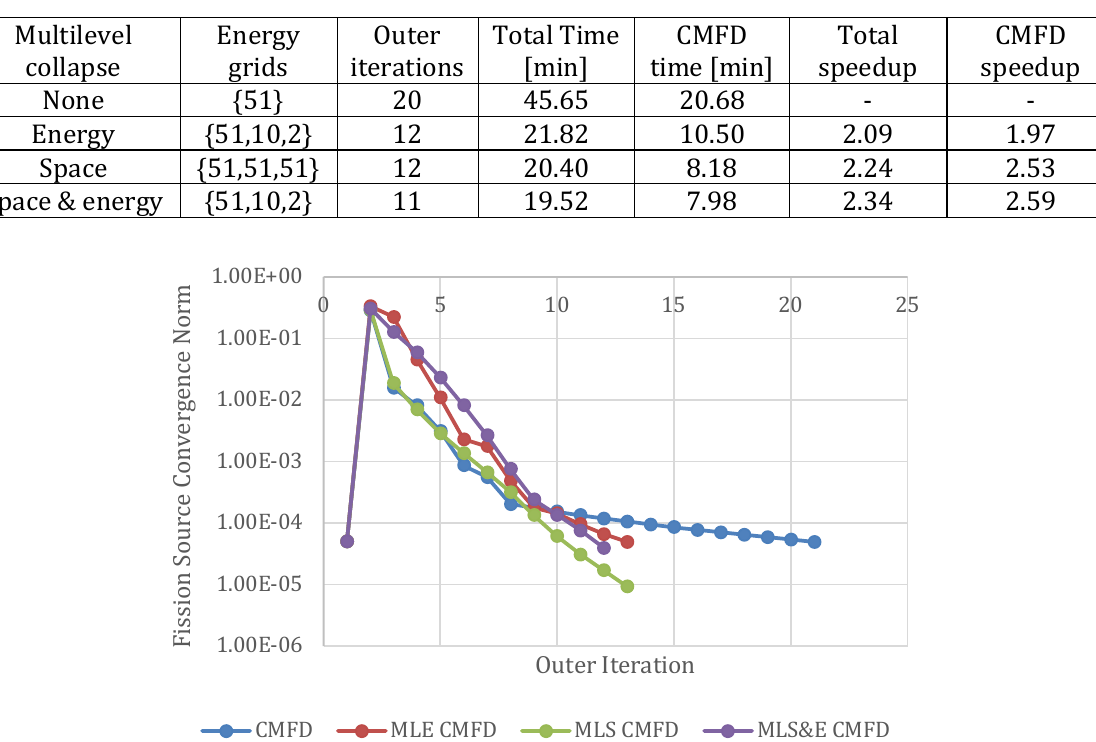
Figure 3. Problem 5 core layout.